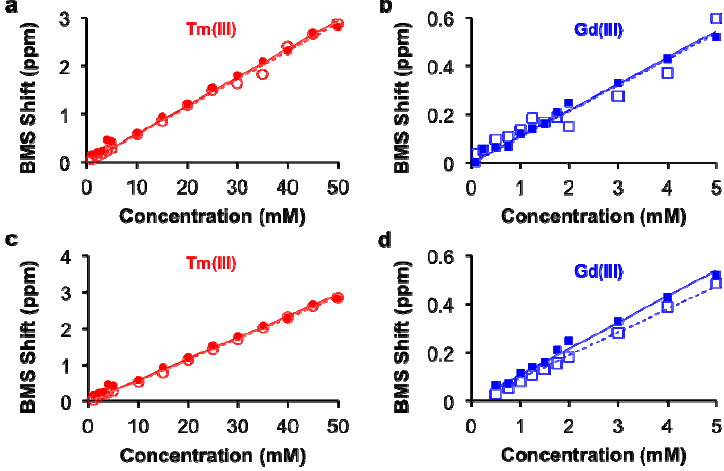
Figure 3. Effect of sample conditions on the concentration-BMS shift calibration. The calibrations of ( a ) Tm(III) and ( b ) Gd(III) without (filled symbols) and with 300 mOsm/L NaCl (open symbols) showed that salt had a neglible effect on the concentration-dependent BMS shift. The calibrations of ( c ) Tm(III) and ( d ) Gd(III) without (filled symbols) and with 90 μ M albumin (open symbols) showed that proteins had a neglible effect on the concentration-dependent BMS